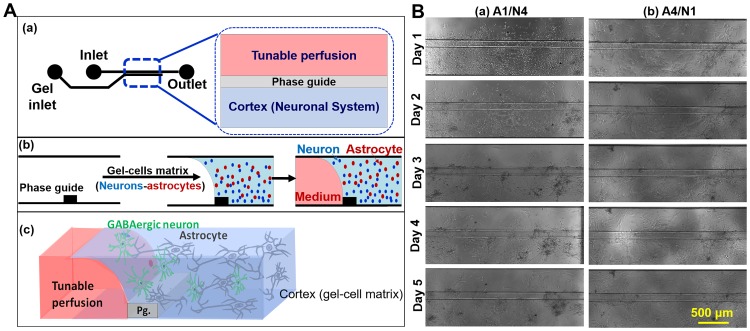
Dynamic 3D brain-on-chip platform using human iPSC-derived GABAergic neurons and astrocytes.(A) Schematic of 3D brain-on-chip platform and brain tissue construct used for high-content MT toxicity and BuChE bioscavenger testing. (B) Bright-field images of brain tissue constructs with different ratios of human iPSC-derived neurons and astrocytes (1:4 (a) and 4:1(b)) taken over the course of 5 days.